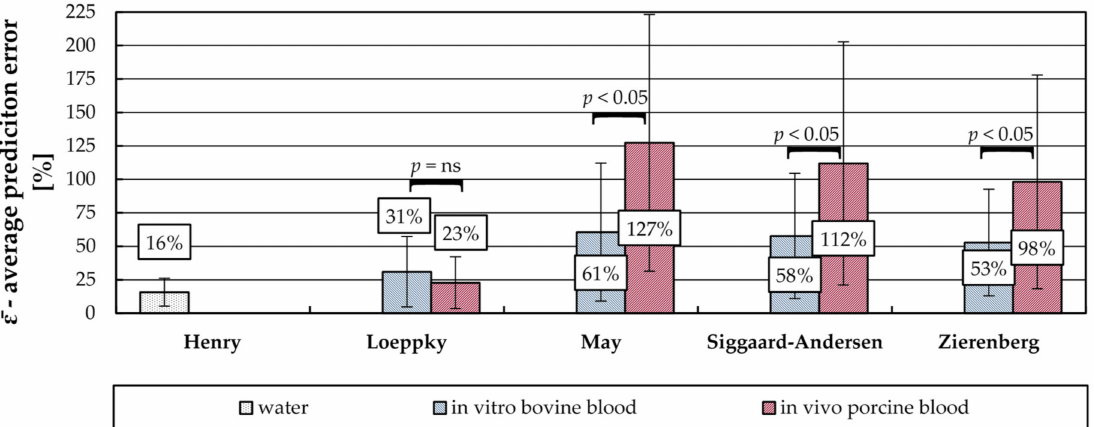
Figure 5. Average prediction error of the different CO 2 solubility models for in vitro tests with water and bovine blood as well as in vivo tests with porcine blood. The error bars show the standard deviation. Difference of average prediction error between test series was tested for significance with Welch’s t -test. Games-Howell test gives that prediction error of Loeppky model is significantly lower ( p -value < 0.01) than that of the other models for both in vitro and in vivo